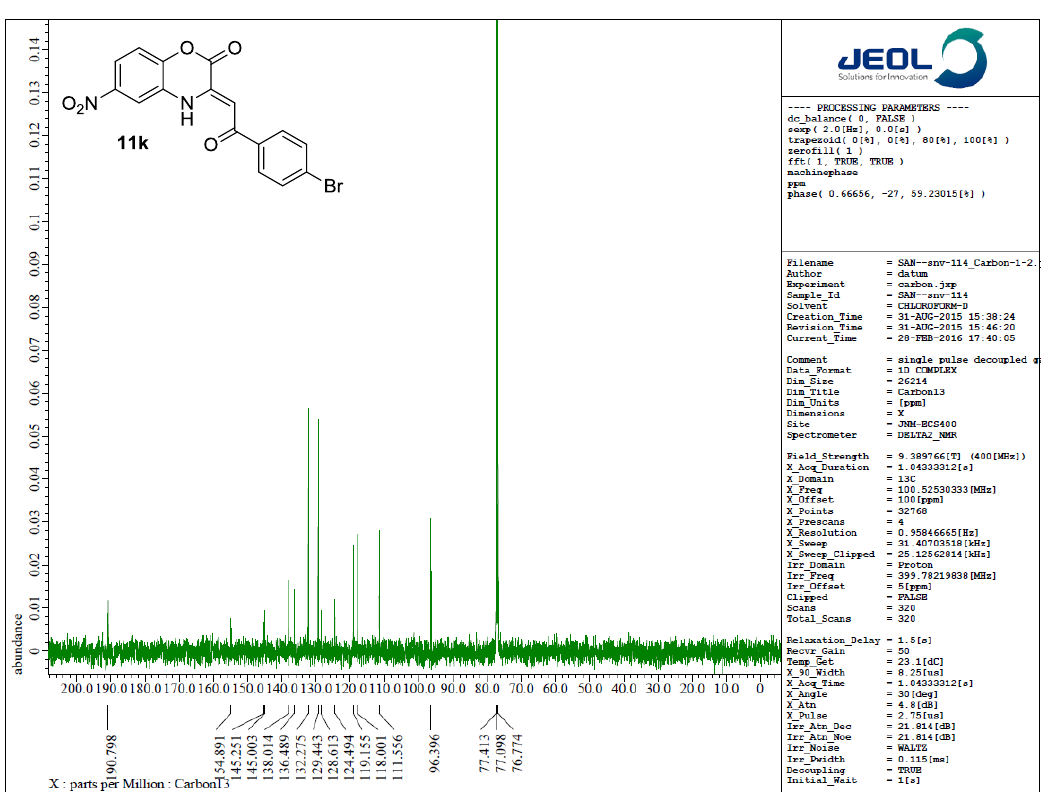
Figure 22. 13 C NMR Spectra of Compound